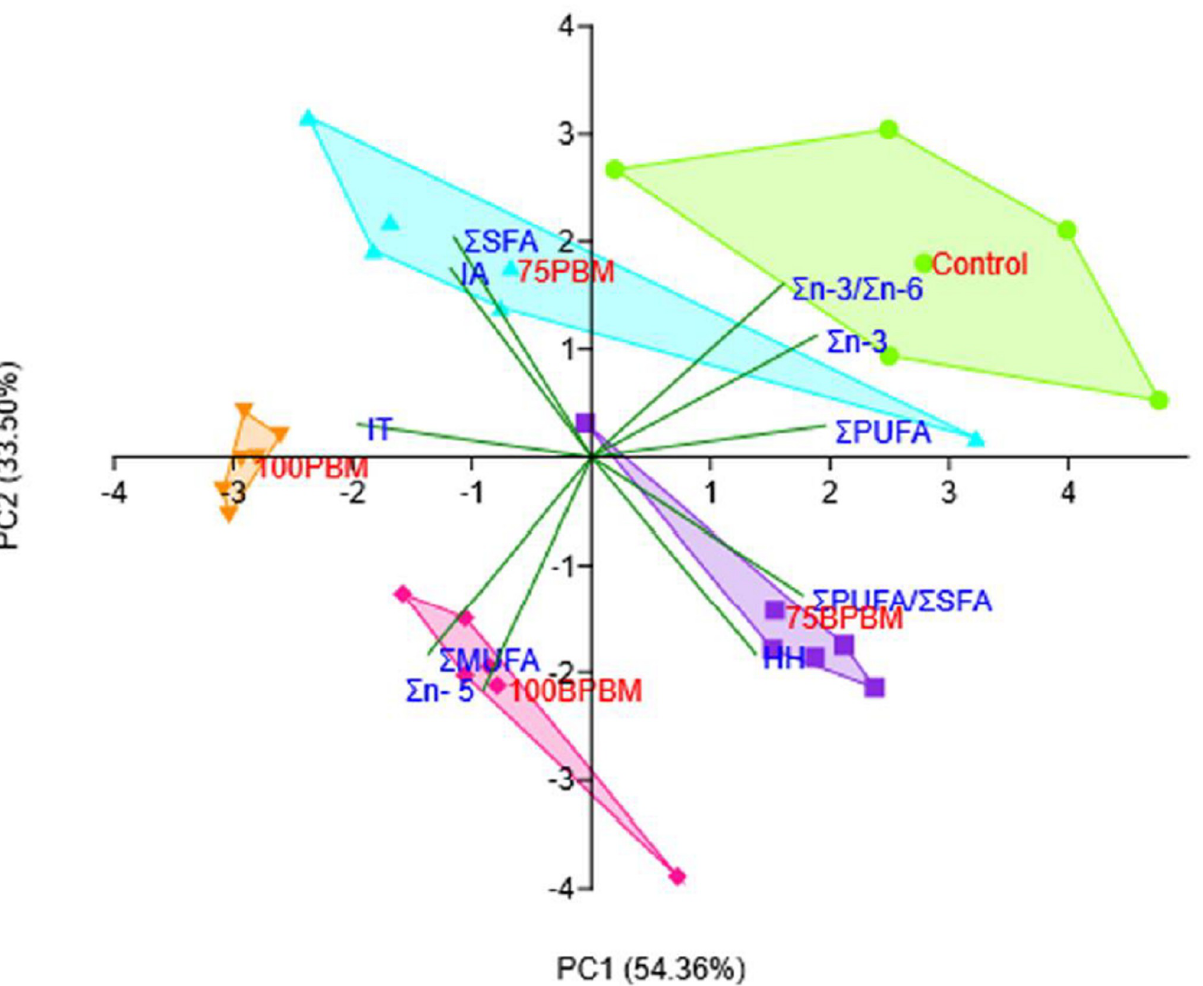
Fig 2. Graphical representation of first two principal components (PC1-PC2) biplot of fatty acid composition in juvenile barramundi fed with different levels of bioprocessed and unprocessed PBM. The figure depicts positive and negative association between variables and clustering between samples based on score obtained from analysis. Different markers represent samples from different dietary treatments used in the analysis and vectors indicate how the variables contributed to the formation of PC1 and PC2.